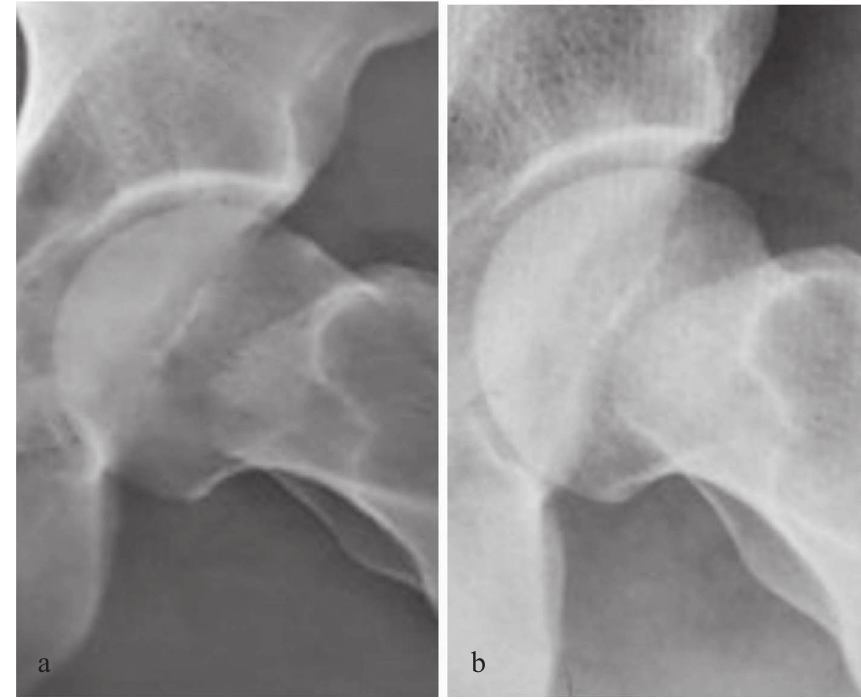
Figure 3. Plain X -ray frog view of the left hip joint preoperative (a), postoperative (b) after arthroscopic Cam